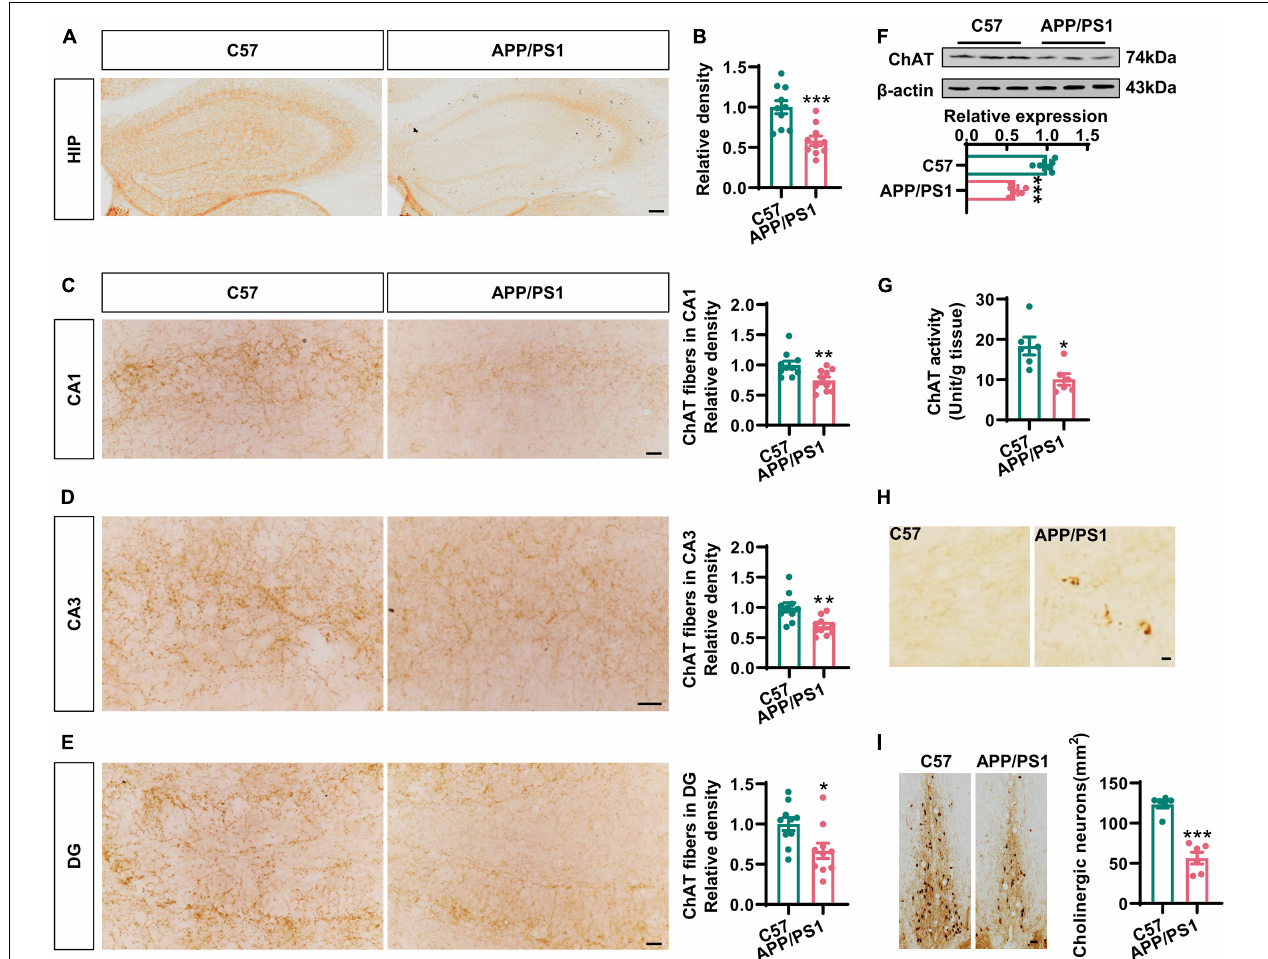
FIGURE 1 | The cholinergic dysfunction was impaired in the hippocampi of AD mice. (A) Representative immunohistochemical images in the hippocampi stained with anti-ChAT antibody from APP/PS1 mice and age-matched C57 mice. Bar = 100 µ m. (B) The relative density of ChAT fibers was analyzed by ImageJ. Unpaired Student’s t -test, n = 10 from four to five mice for each group, *** p < 0.001. (C–E) Representative immunohistochemical images in CA1, CA3, and DG stained with anti-ChAT antibody; the relative density of ChAT fibers was analyzed in CA1 (C) , CA3 (D) , and DG (E) . Bar = 20 µ m. Unpaired Student’s t -test, n = 10 from six mice for each group, ** p < 0.01 and * p < 0.05. (F) The protein level of ChAT in the hippocampi was measured by western blotting, and the quantitative analysis was performed in the lower panel. Unpaired Student’s t -test, n = 6 mice for each group, *** p < 0.001. (G) The ChAT enzyme activity in the hippocampi was measured by an ELISA kit. Unpaired Student’s t -test, n = 6 mice for each group, * p < 0.05. (H) Representative immunohistochemical images of dystrophic neurites in the hippocampi stained with anti-ChAT antibody from APP/PS1 mice and age-matched C57 mice. Bar = 10 µ m. (I) Representative immunohistochemical images of ChAT-positive neurons in the basal nucleus of Meynert stained with anti-ChAT antibody. The quantitative analysis was performed and shown in the right panel. Bar = 50 µ m. Unpaired Student’s t -test, n = 6 mice for each group, *** p < 0.001.